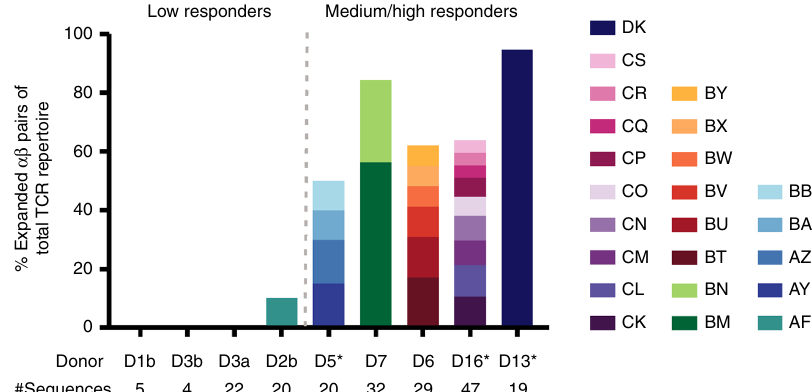
Fig. 6 Level of expanded TRBV-TRBJ/TRAV-TRAJ clonotypes. Frequency of expanded TRBV-TRBJ/TRAV-TRAJ clonotypes observed in the total sequenced TCR αβ repertoire within each donor ( n = 8). Letters in legend correspond with clone ID in Table 2. Total number of sequences within each donor is indicated below the graph. An asterisk indicates that TCR clonotypes were established on in vitro expanded T cell in fl uenza immunisation would not affect CD8 + T cell responses tested in this study. Protein expression, puri fi cation, and crystallization . Soluble class I hetero- dimers of HLA-A*68:01-containing NP 145 peptide were prepared by expressing the heavy chain and the β 2-microglobulin proteins separately as inclusion body in a BL21 E. Coli strain. After several washes, the inclusion bodies were solubilized in 6M guanidine before being use for refold. The refolding buffer contained 0.1 M Tris-HCl pH8, 2 mM EDTA, 400 mM L-Arginine-HCl, 0.5 and 5 mM Glutathione oxidized and reduced, respectively. Into the chilled refolding buffer was added 90mg of heavy chain inclusion bodies; 20mg of β 2m inclusion bodies, and 10 mg of the NP 145 peptide (purchased from GLbiochem) dissolved in 400 μ L of DMSO. After 3 days, the protein was dialyzed and puri fi ed using anion exchange and size exclusion columns. Crystals of the HLA-A*68:01-NP 145 grew at 2.5mg/ml in 8 – 14% v/w PEG3350, 0.1M NaCl, 0.1M Hepes pH 7.4, 20 mM MgCl 2 , and 5 mM CdCl 2 . The crystals were soaked into a cryoprotectant solution containing the mother liquor solution enriched at 25% v/w PEG3350, and fl ash frozen in liquid nitrogen. Data were collected on the MX2 beamline 58 at the Australian Synchro- tron, Clayton using an ADSC 315r CCD detector (at 100 K). Diffraction data were processed using XDS software 59 , and scaled with SCALA software 60 from the CCP4 suite 61 . The structure of HLA-A*68:01-NP 145 complex was solved by molecular replacement using PHASER (S0907444901012471) with the previously solved structure of HLA-A*68:01 as model (PDB accession number 4HWZ 62 ) without the bound peptide. The model was re fi ned with Buster software 63 after multiple manual model building run to fi t the NP 145 peptide in the structure using Table 1. All molecular graphics representations were created using MacPyMOL v1.7.6.3 65 . Viral sequence analysis . To assess the frequency of amino acid variations in the NP 145 peptide in human A/H1N1 (1918 – 1957, 1977 − 2009, and 2009 – 2018), A/ H2N2 (1957 – 1968), A/H3N2 (1968 – 2018), H5N1 (1997 – 2014) and H7N9 (2013 – 2017) viruses, all full-length NP amino acid sequences available in the in fl uenza virus resource database of the National Center for Biotechnology Infor- mation (NCBI; http://www.ncbi.nlm.nih.gov/genomes/FLU), as of 31 July 2018, were downloaded. Sequences with large deletions were excluded using BioEdit, the remaining dataset was analyzed in Ugene 1.16.1 (http://ugene.unipro.ru; Unipro, Novosibirsk, Russia) to assess the frequency of variations at different positions in the NP 145 peptide. Viruses were analyzed in Excel to determine whether observed frequencies were the result of cluster formation and whether certain mutations became fi xed in time. Peptides and tetramers . Variants of the IAV NP 145 peptide (DATYQRTRALVR, D TTYQRTRALVR, and DVTYQRTRALVR) were purchased from GenScript (Piscataway, NJ, USA). HLA − A*68:01-NP 145 (DATYQRTRALVR) monomers were generated in house by refolding each peptide with its restricted HLA α -heavy chain-BirA and β 2-microglobulin 66 before 8:1 conjugation with PE-streptavidin or APC-streptavidin (BD Biosciences, San Jose, CA, USA) to form tetramers. Generation of T cell lines . To amplify in fl uenza virus-speci fi c CD8 + T cells directed at the HLA-A*68:01-restricted NP 145 epitope, autologous PBMCs (~3 × 10 6 cells) from HLA-A*68:01 donors were pulsed with 10 μ M NP 145 peptide (DATYQRTRALVR, DTTYQRTRALVR or pool of DATYQRTRALVR,